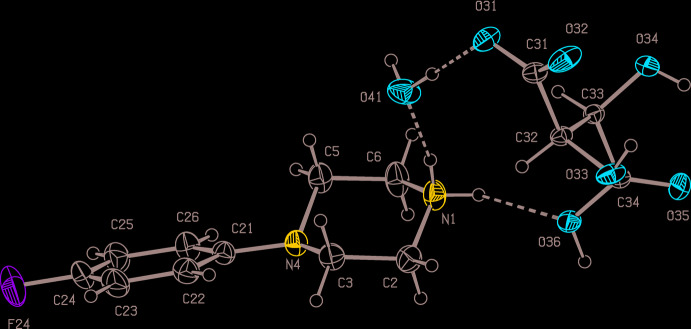
The independent components of compound (III) showing the atom-labelling scheme and the hydrogen bonds (drawn as dashed lines) within the asymmetric unit. Displacement ellipsoids are drawn at the 30% probability level.